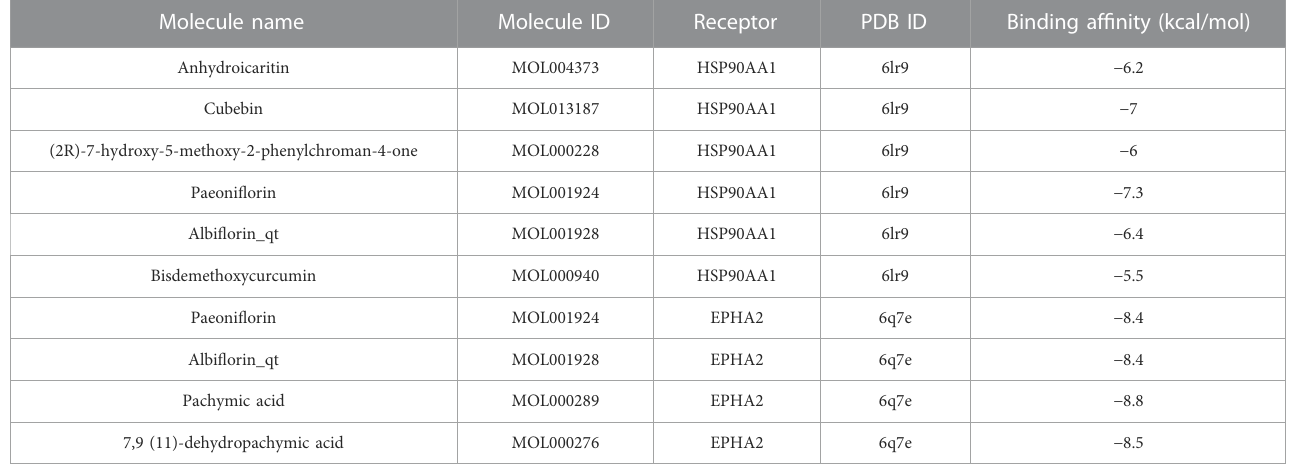
TABLE 1 Docking scores of key compounds and targets in hepatocellular